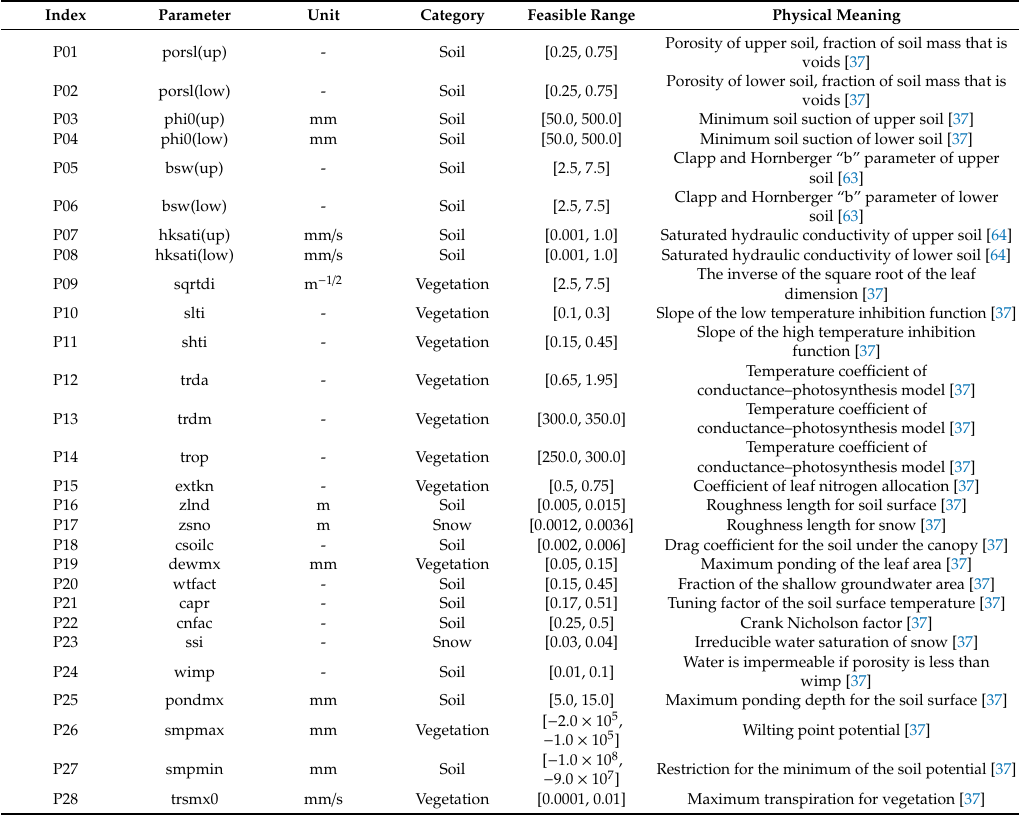
Table 2. Parameter descriptions and their ranges for the Tibetan Plateau (TP) sites in the CoLM